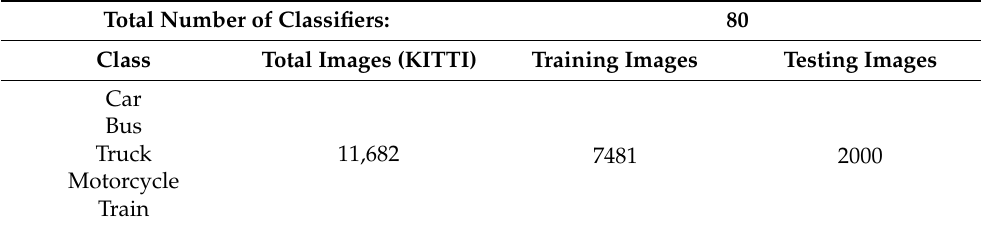
Table 3. Class-wise distribution of KITTI datasets.